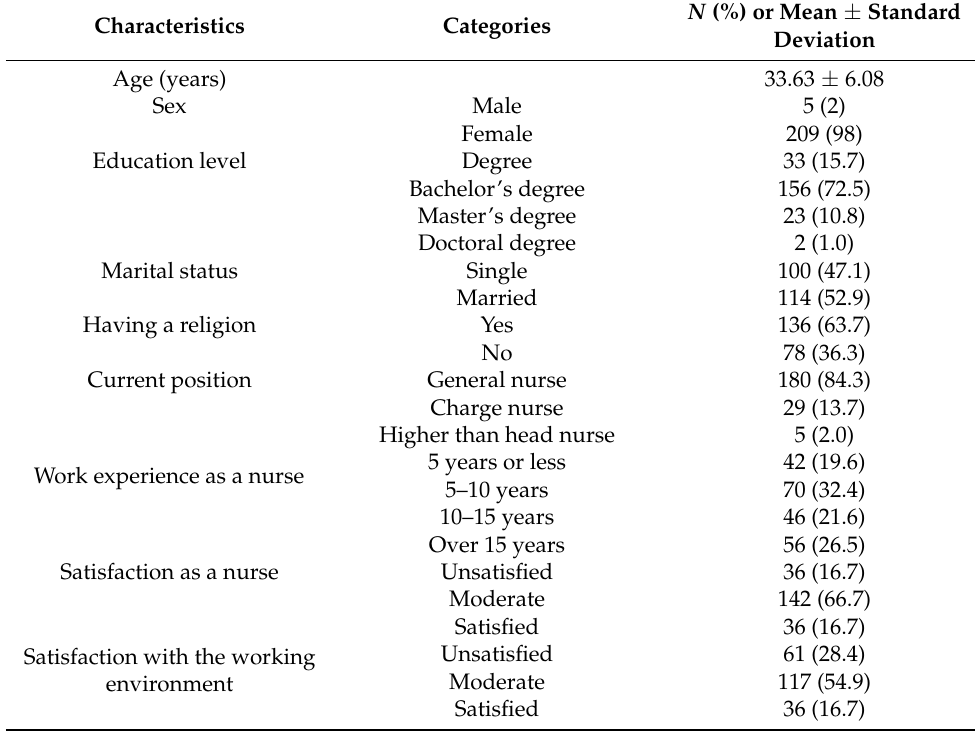
Table 1. General characteristics of participants ( N =